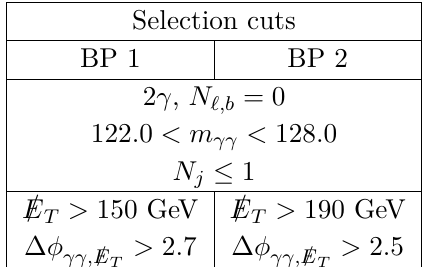
Table 19. The selection cuts optimised in the γγ + /E